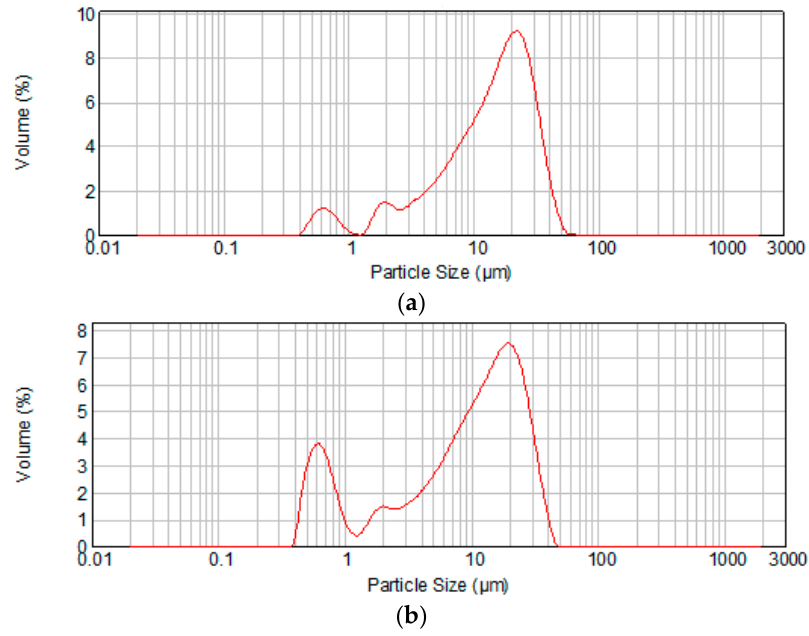
Figure 1. Grain size distribution of MTA cements obtained at: ( a ) 1400 °C/2 h (MTA1); ( b ) 1450 °C/3 h (MTA2).